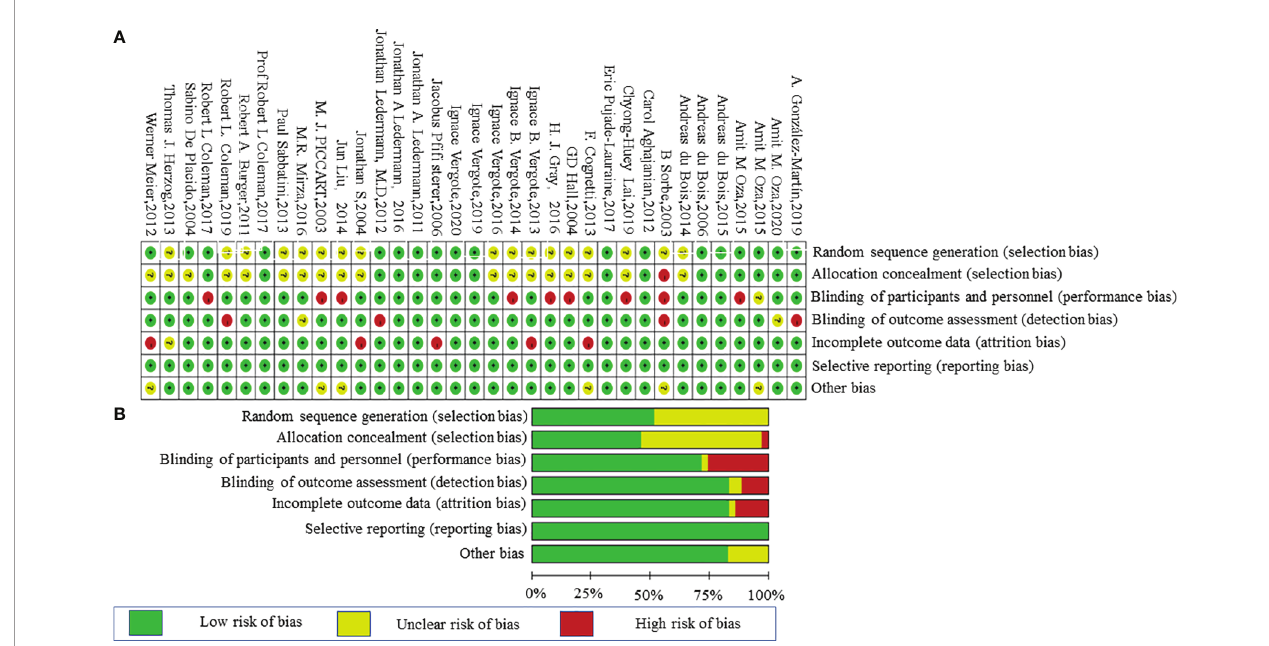
FIGURE 2 | Risk-of-bias graph. (A) Review authors ’ judgments about each risk-of-bias item presented as percentages across all included studies. (B) Review of authors ’ judgments about each risk-of-bias item for each included study.